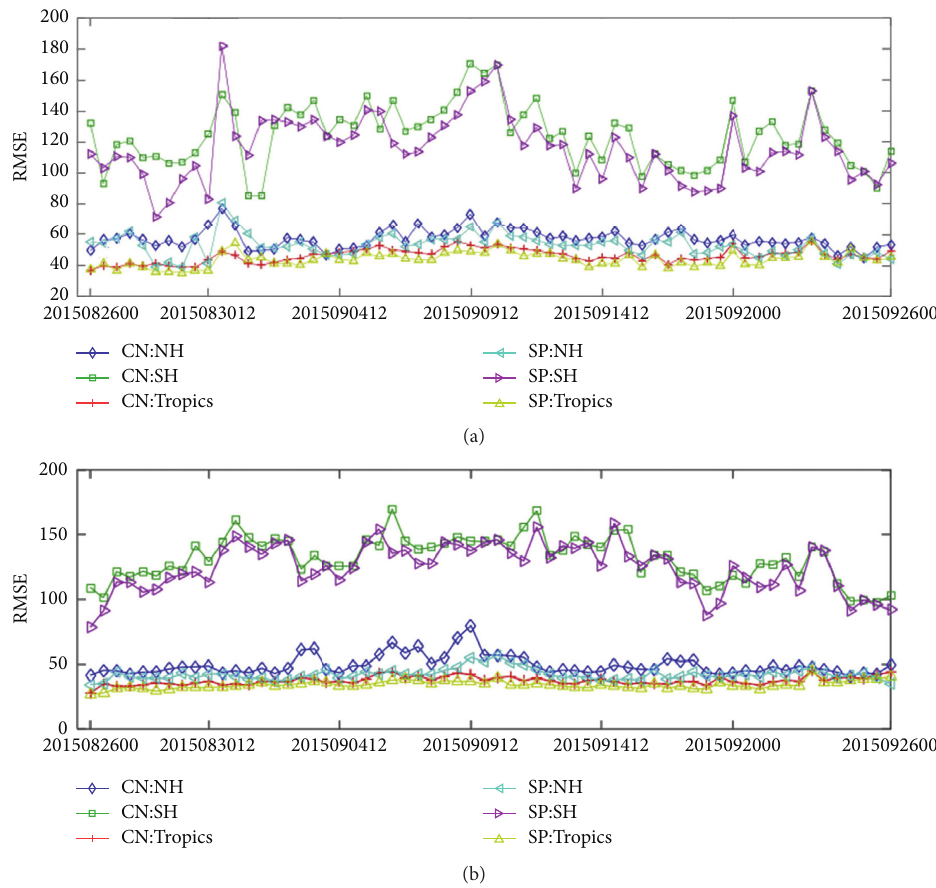
Figure 11: The RMSE of the 500hPa geopotential height in different regions. (b) is the same but at